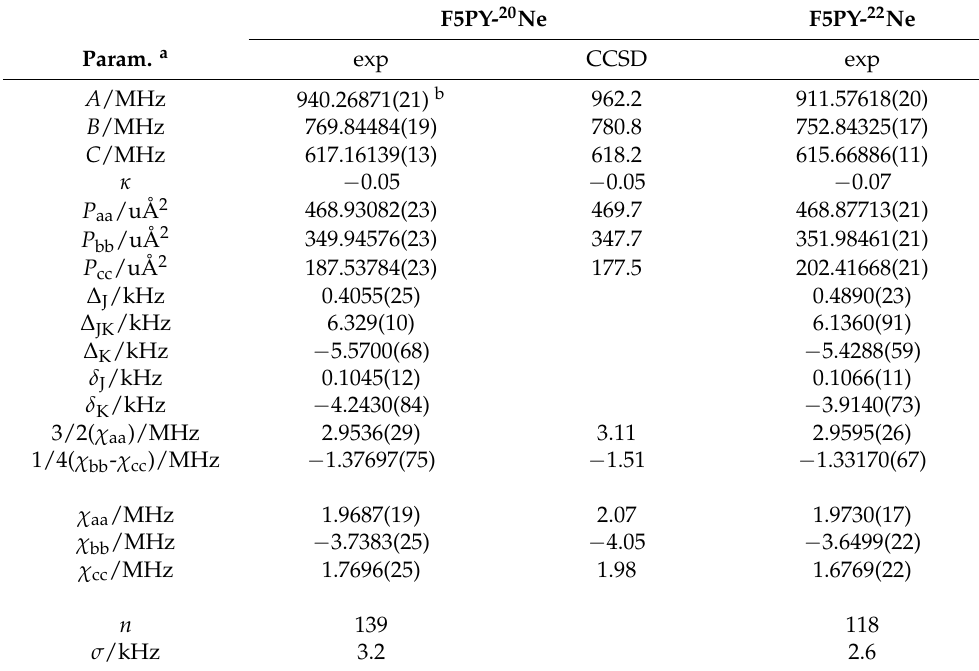
Table 1. Experimental rotational parameters for the F 5 PY- 20 Ne and F 5 PY- 22 Ne isotopologues and their comparison to the predicted CCSD/6-311++G(2d,p) values for the parent species (Figure 2). F5PY- 20 Ne F5PY- 22 Ne